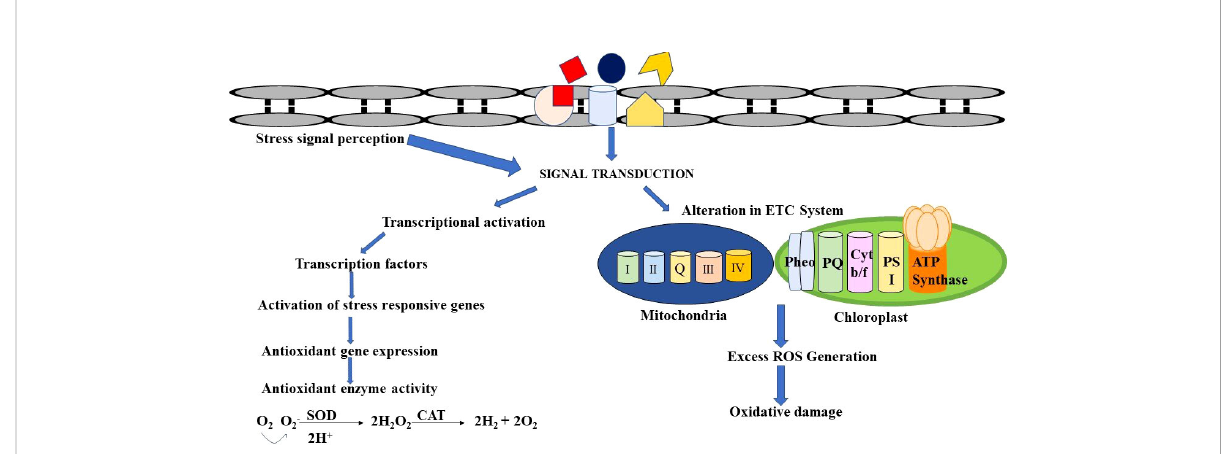
FIGURE 2 Schematic representation of defense mechanisms to counteract heavy metal